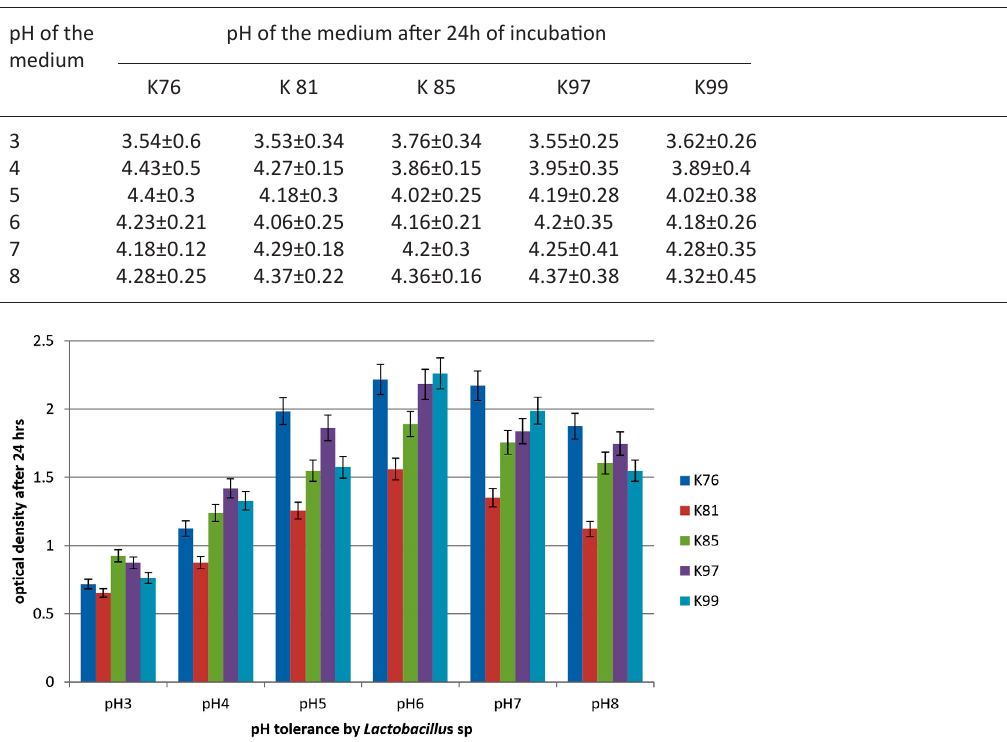
Fig. 1. Tolerance of Lactobacillus mucosae (K76), L. fermentum (K81), L. fermentum (K85), L. reuteri (K97) and L. reuteri K99) to different pH. Error bars indicate ± standard deviation.